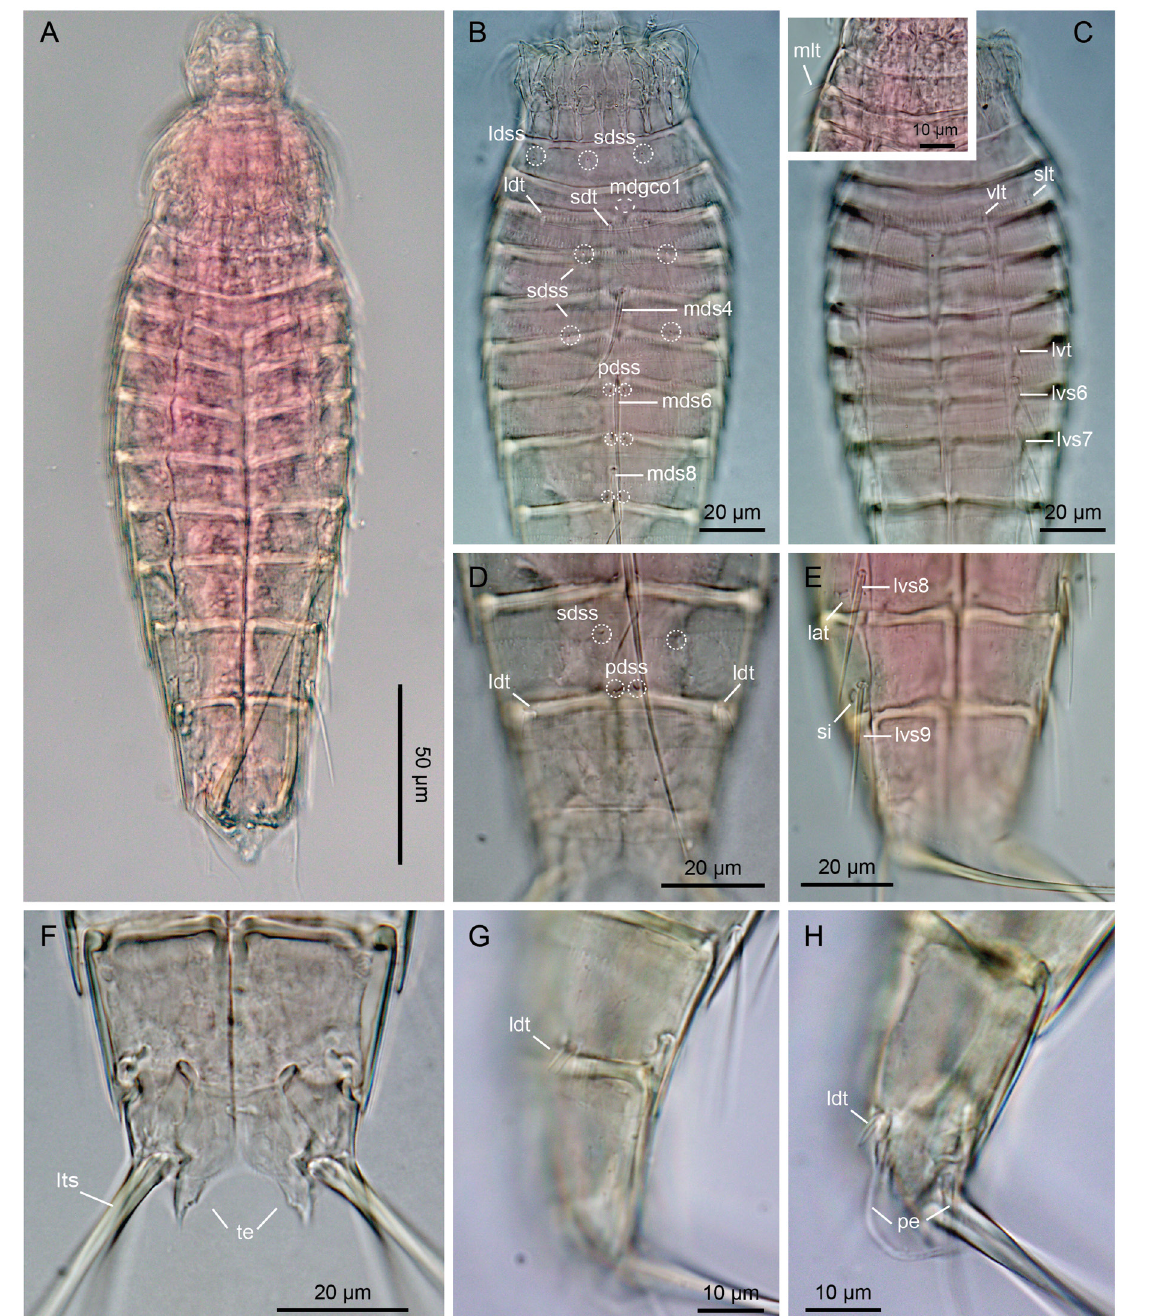
Fig. 18. Light micrographs showing overview and details of Echinoderes frodoi sp. nov. A, C (close- up). ♂, holotype (NIWA-159414). B–D, F . ♀, paratype (NHMD-916336). E . ♀, paratype (NHMD- 916335). G–H . ♂, paratype (NIWA-159416). A . Ventral overview. B . Segments 1 to 8, dorsal view. C . Segments 1 to 8, ventral view with close-up showing midlateral tube on segment 1. D . Segments 9 to 10, dorsal view. E . Segments 8 to 10, ventral view. F . Segments 10 to 11, ventral view. G . Segments 9 to 10, lateral view. H . Segments 10 to 11, lateral view. Abbreviations: see Material and